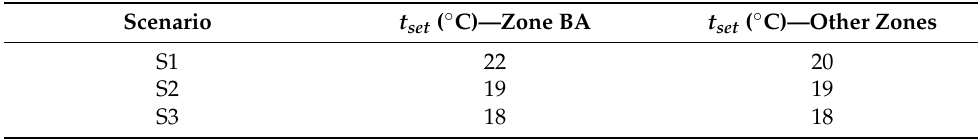
Table 5. Set-point temperatures of thermal zones of the